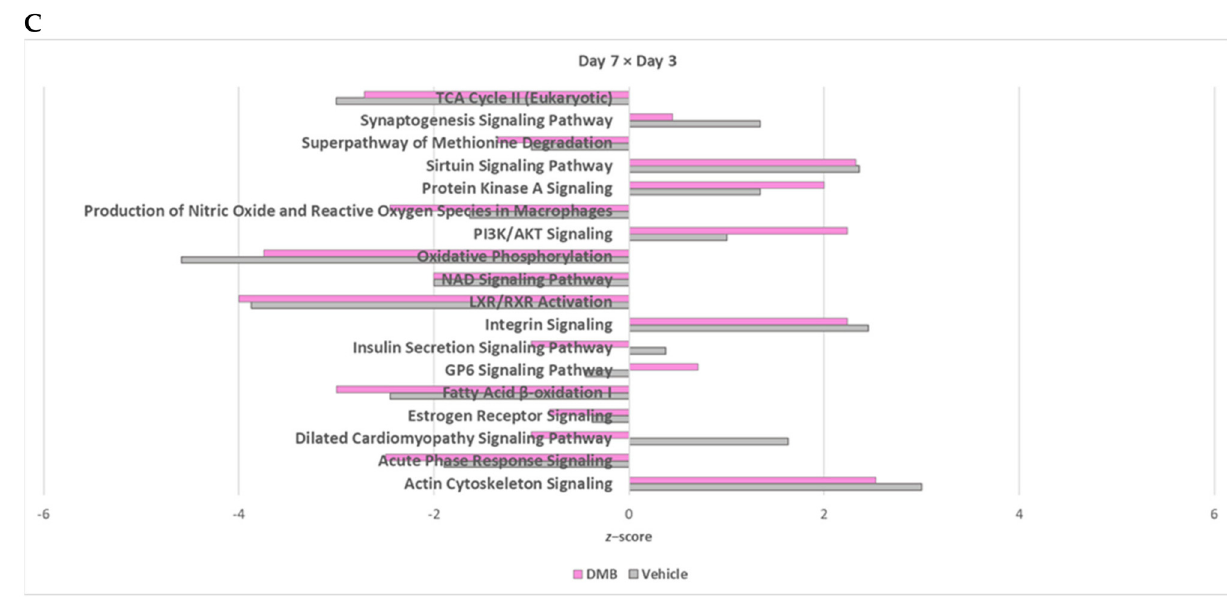
Figure 3. Common IPA canonical pathways with predicted z -scores for the course of early remodeling in each group. The expression of proteins from each time point was compared to its preceding time point intragroup. The DEPs and unique proteins identified in each comparison were uploaded on IPA for subsequent core analysis and z -scores were identified. z -scores higher than 0 predict activation and z -scores lower than 0 predict inhibition of a pathway. ( A ) Common canonical pathways of day 1 post-PCAL vs. naïve hearts; ( B ) common canonical pathways of day 3 post-PCAL vs. day 1 post-PCAL hearts; ( C ) common canonical pathways of day 7 post-PCAL vs. day 3 post-PCAL hearts. Table 1. Unique canonical pathways with predicted z -scores throughout the course of remodeling. Vehicle DMB Pathway z -Score Pathway z